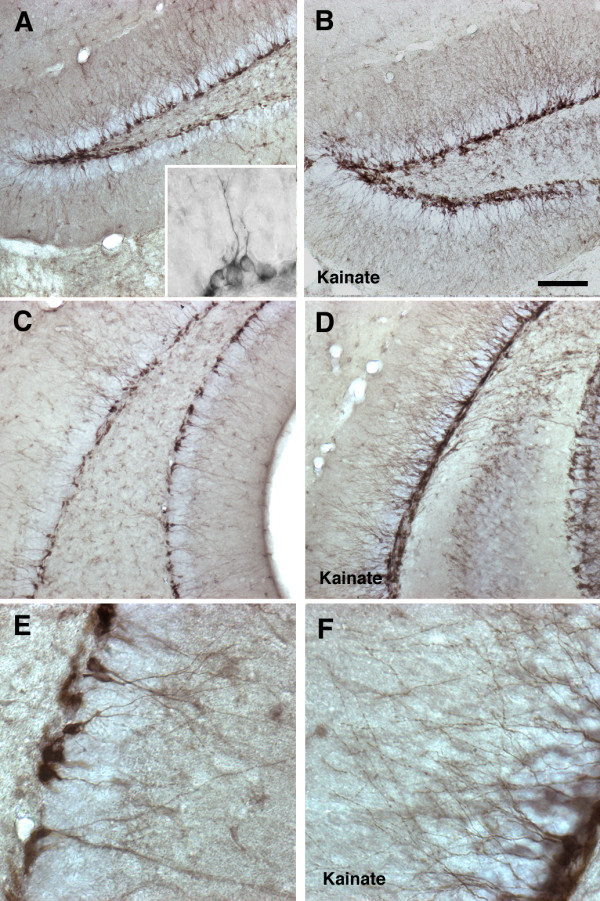
DCX-expressing cells in the subgranular zone. Column A, C, D shows normal conditions, column B, D, F shows conditions after induction of seizures by kainate application. A and C, DCX-positive cells in the subgranular zone (SGZ) with dendrites of various lengths reaching into the molecular layer. The nucleus appears usually devoid of immunoreaction. The granule cell layer is seen as a light band. Scale bar (in B for all panels), 150 μm. Insert, high power depiction of a cluster of DCX-positive cells of different morphology. Note, how the initial segment of the dendrite grows parallel to the SGZ. Scale bar, 45 μm. B and D, Kainate application increases the number of DCX-positive cells in the SGZ (here at 10 days after seizure induction). The SGZ widens and occasionally shows a bi-layered structure. Scale bar, 150 μm. E and F, Kainate injections increase the number of DCX-positive cells but do not seem to cause abnormal growth of the apical dendrites. Scale bar, 80 μm.